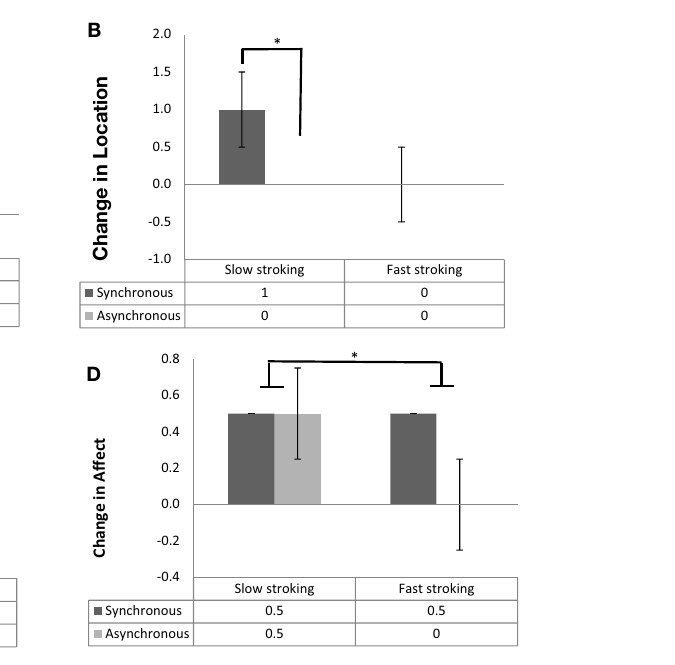
interquartile range (error bars) of change in agency scores for synchronous (dark gray bars) and asynchronous (light gray bars) stroking. (D) Median and interquartile range (error bars) of change in affect scores for synchronous (dark gray bars) and asynchronous (light gray bars) stroking, panels (A–C) : ∗ p < 0 . 001, panel (D) : ∗ p = 0 .